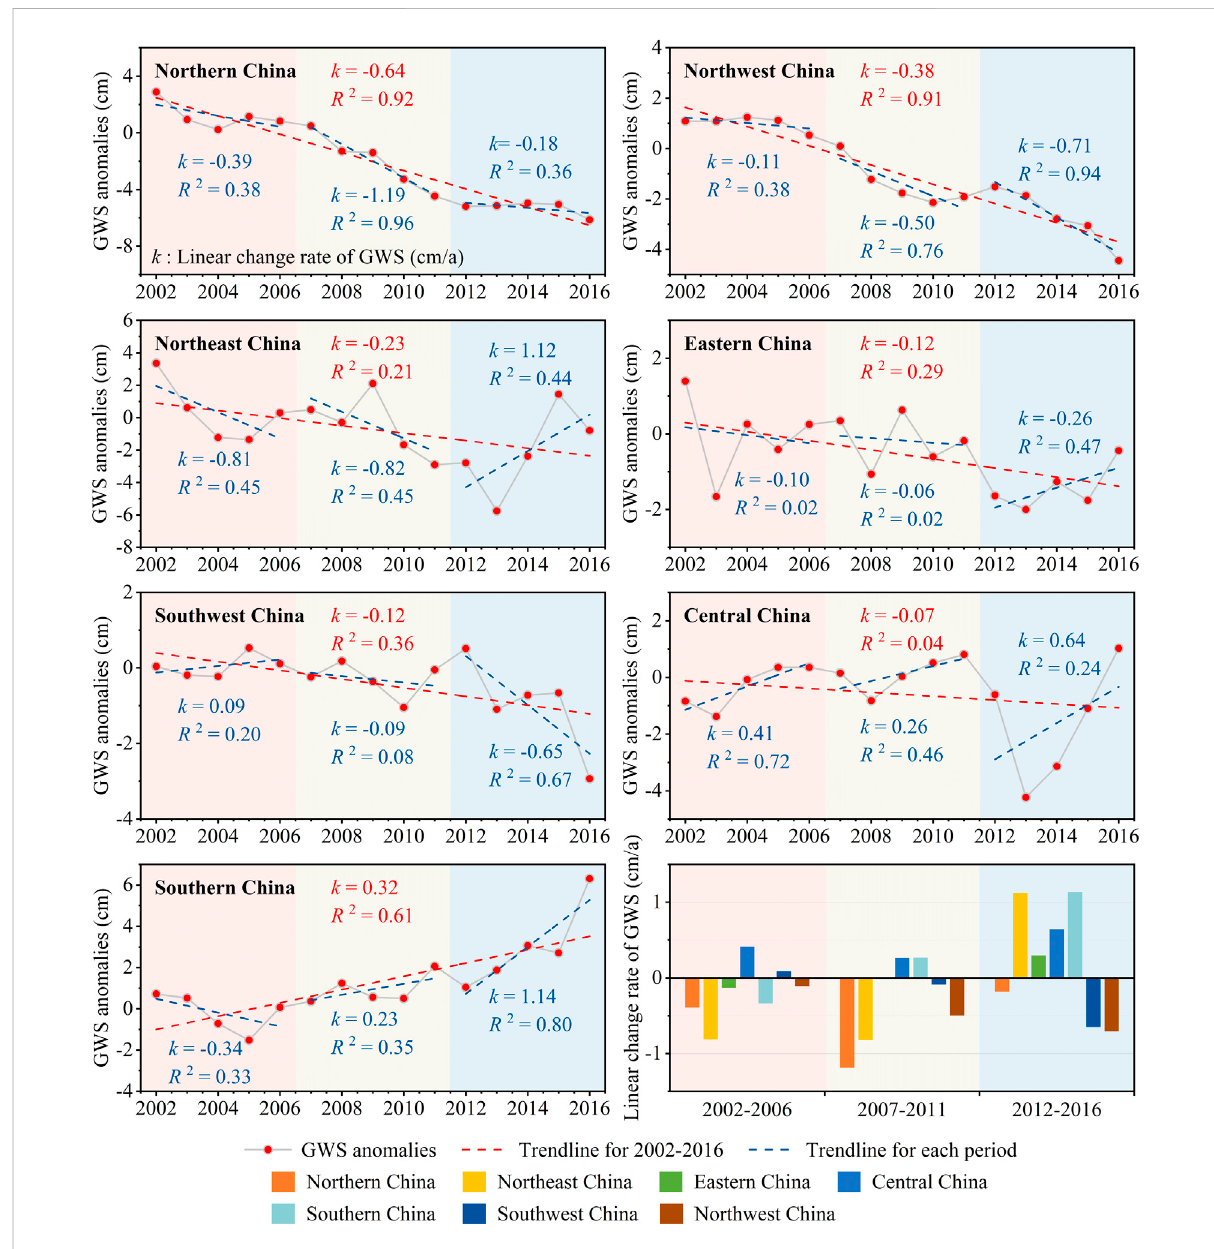
FIGURE 6 Change and linear fi t of the GWS derived from GRACE in the seven regions of